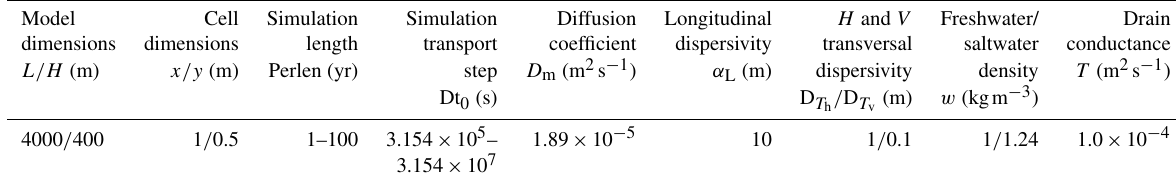
Table 3. Hydrogeological model simulation parameters. Model Cell Simulation Simulation Diffusion Longitudinal H and V Freshwater/ Drain dimensions dimensions length transport coefficient dispersivity transversal saltwater